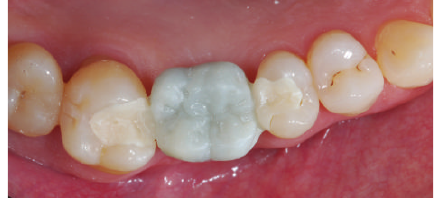
Figure 5: Occlusal view of the try-in seated in the oral cavity.